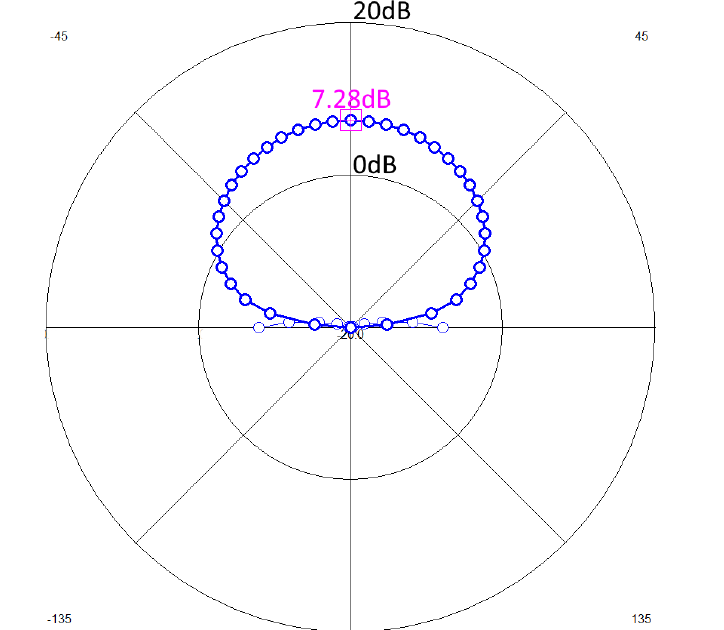
Figure 2. Gain pattern of the proposed antenna design at 2.4GHz